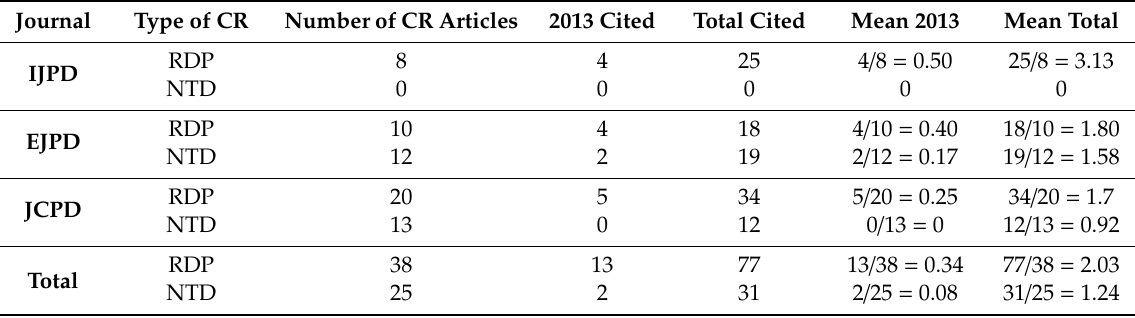
Table 3. Major PD journals’ citations of rare disease or pathology (RDP) and new treatment or diagnostic method (NTD)